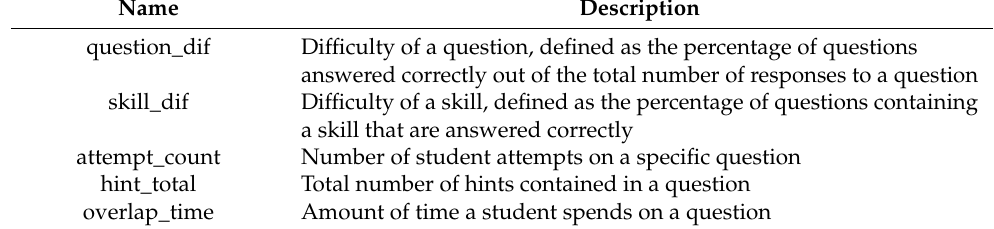
Table 1. Feature Introduction.